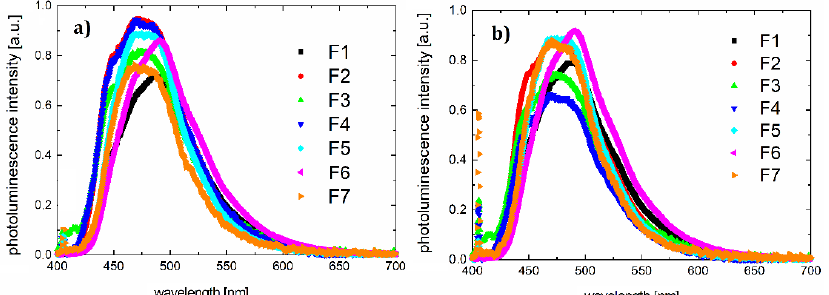
Figure 3. Photoluminescence spectra for samples F1–F7 in ( a ) chloroform and ( b ) thin film on quartz ( λ ex = 405